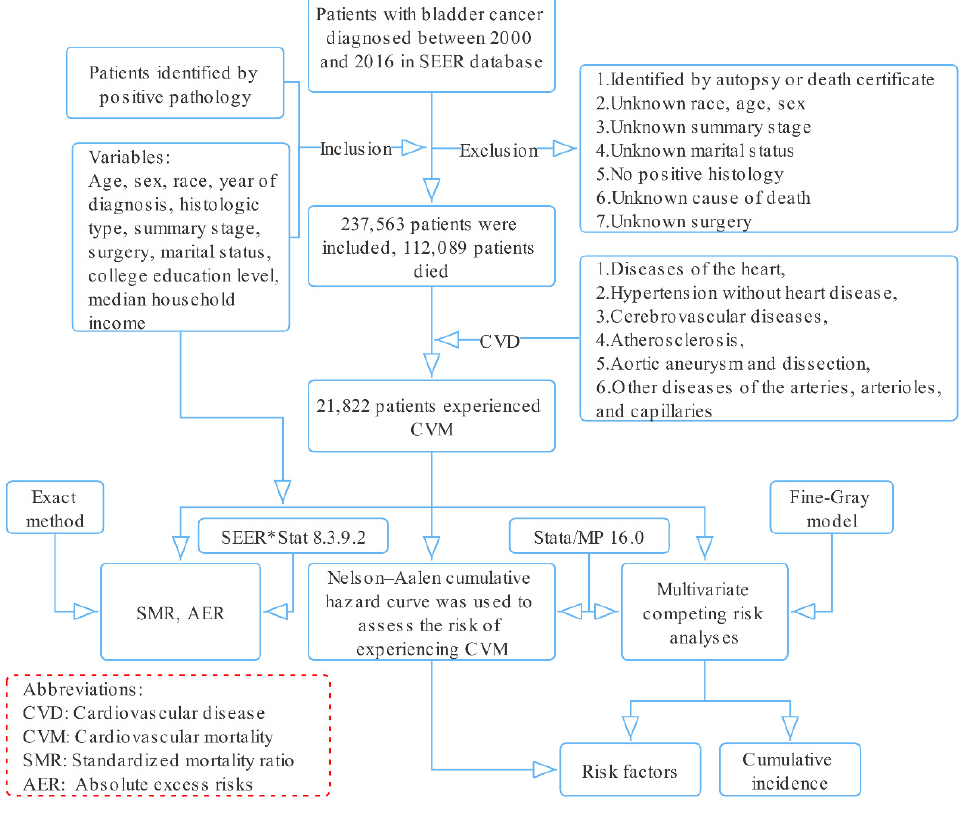
Figure 1. Selection of eligible patients and study design.